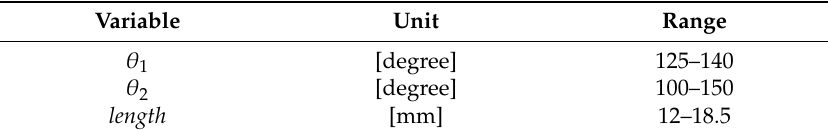
Table 4. Range of design